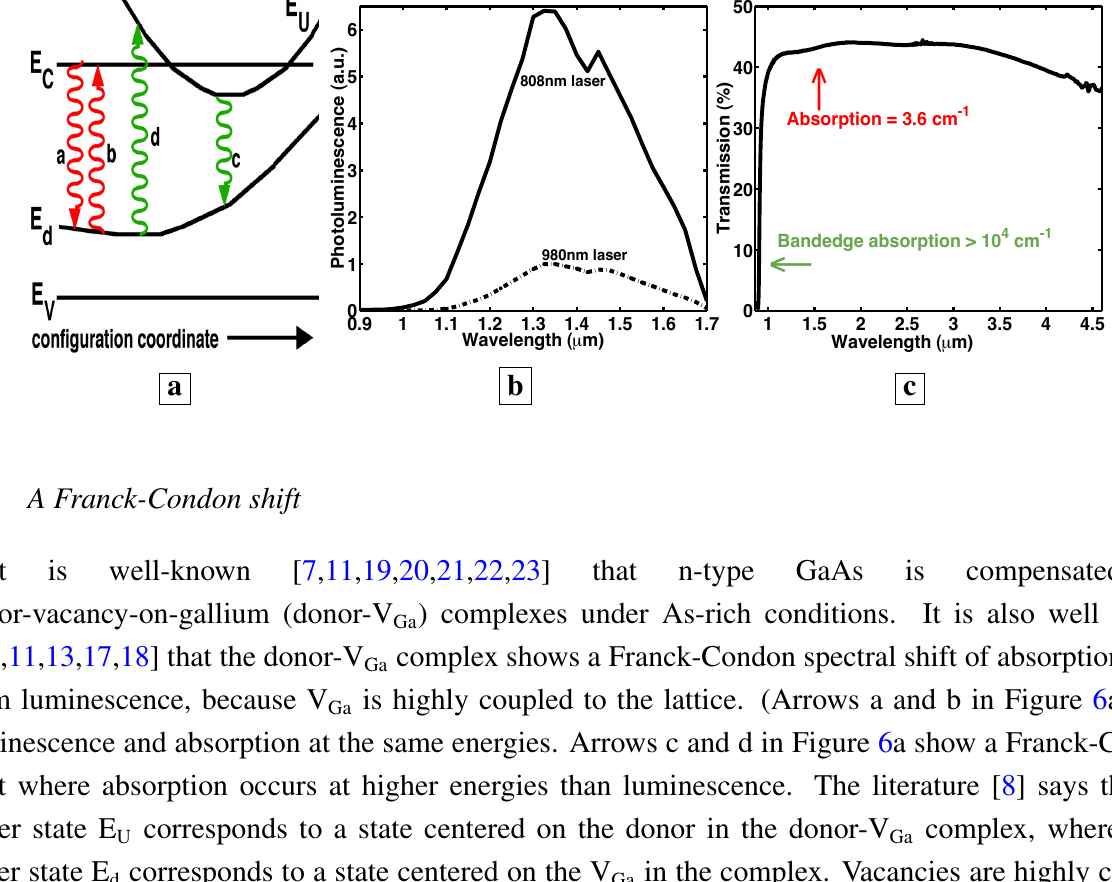
Figure 6 . The donor-V complex is known [8] to show a Franck-Condon shift [7]. a, Ga Arrows c and d show a Franck-Condon spectral shift of absorption away from luminescence. b, Photoluminescence [7] at different excitation wavelengths from the GaAs deep-centers. The excitation at 808 nm (solid curve) yields much brighter PL than the excitation at 980 nm (dashed curve). The new material absorbs efficiently only at short wavelengths ( < 980 nm), whereas the PL occurs at long wavelengths (1-1.7 µ m). c, The measured transmission [7] indicates that, at wavelengths (1–1.7 µ m) of bright PL from the GaAs deep-centers, the absorption loss is very